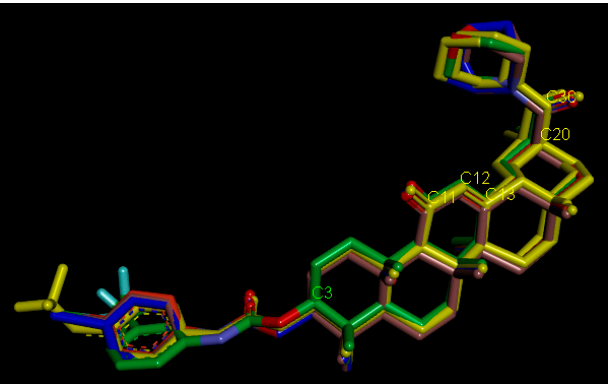
Figure 5. 3D superimposition crystal structure of compounds 4d (brown), 4g (blue), 4h (red), 4j (green), and 4n (yellow). Table 1. Details for the crystal structure determinations of compounds 4d , 4g , 4h , 4j , and 4n